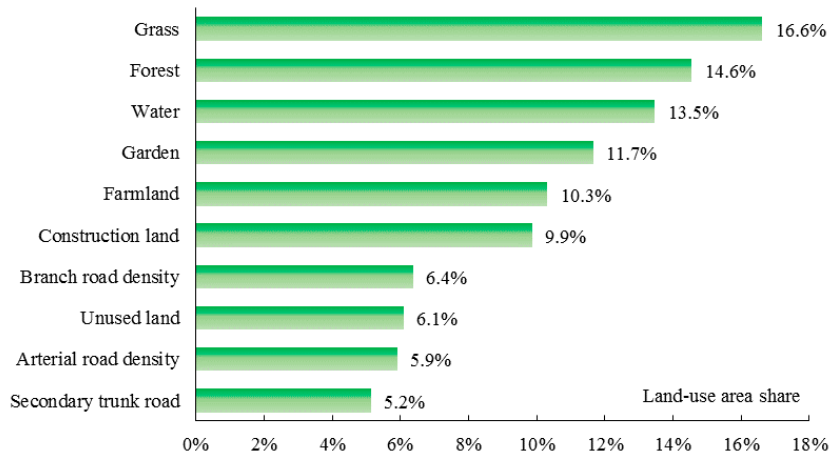
Figure 5. Relative impacts of each land-use distribution on PM 2.5 in spring.